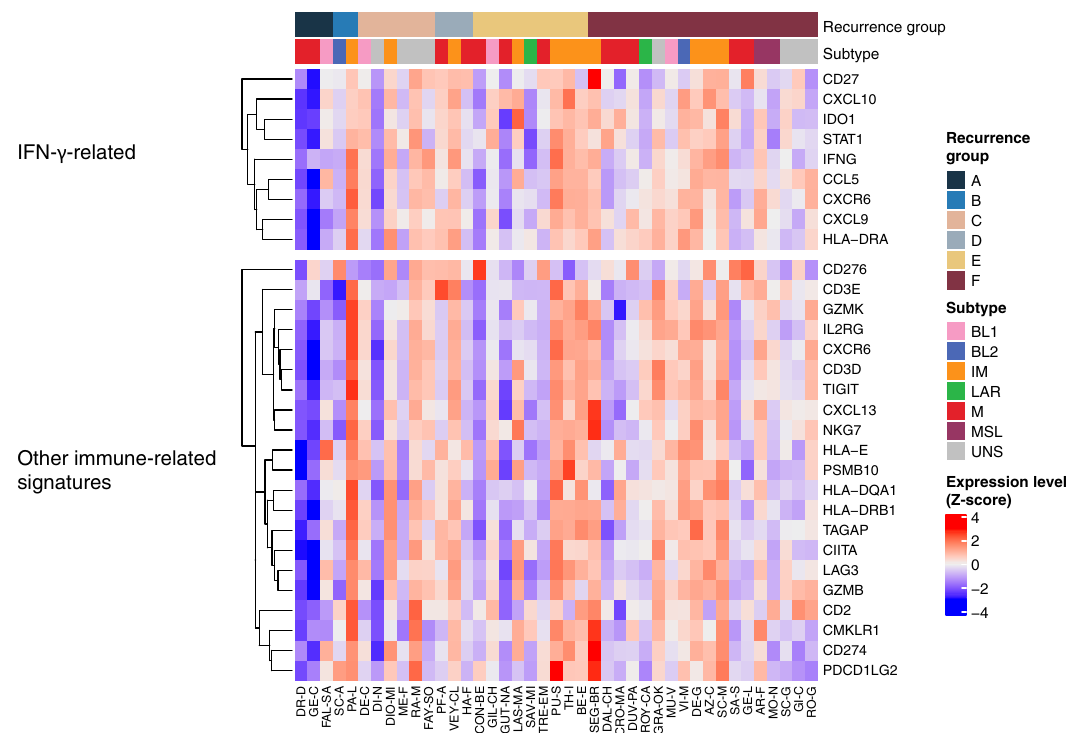
Fig. 4 Expression of the IFN- γ -related and other immune genes. Z-score of expression level was calculated for each gene across all 41 patients. Samples are presented with their original institutional identi fi ers. A – F, recurrence groups; BL1 basal-like 1, BL2 basal-like 2, IM immunomodulatory, LAR luminal androgen receptor; M mesenchymal, MSL mesenchymal stem-like; UNS unclassi fi